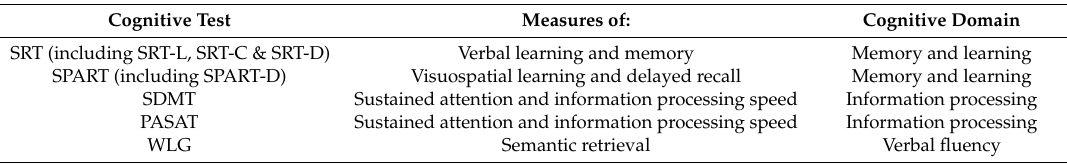
Table 1. Objective and primary cognitive domain of each neuropsychological test in the Brief Repeatable Battery of Neuropsychological tests (BRBNT). Cognitive Test Measures of: Cognitive Domain SRT (including SRT-L, SRT-C &